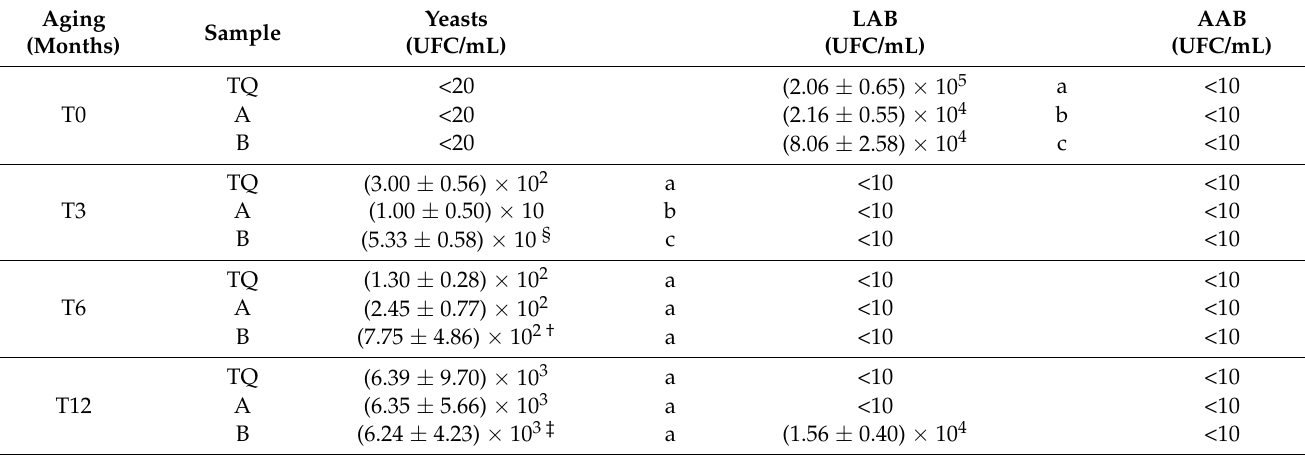
Table 3. Yeasts, lactic acid bacteria (LAB) and acetic acid bacteria (AAB) occurring in wines at 0, 3, 6 and 12 months of aging. Treatments: TQ (SO 2 ); A (UGE, 200 mg/L and chitosan); B (UGE, 400 mg/L). All parameters are given as the mean ± standard deviation. Different letters indicate significant differences among the samples (ANOVA; p <